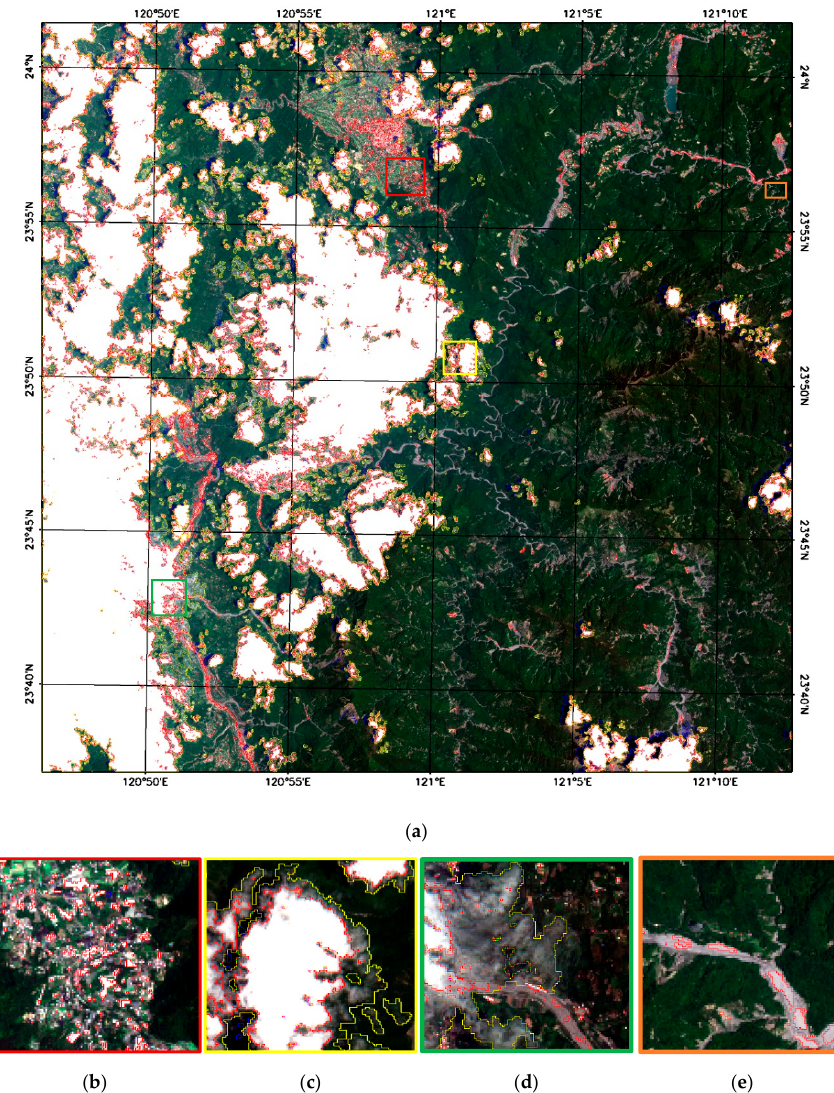
Figure 2. Example of the problems of standard Sentinel-2 Level-2A data products in cloud classification. ( a ) Granule T51QUG and T51QTG taken on 16 May 2018, overlaid by corresponding masks of cloud (red line) and shadow (blue line). The regions of red, yellow, green, and orange boxes are enlarged to illustrate ( b ) the case of misclassified clouds over bright targets; ( c ) the case of misclassified thin clouds; ( d ) the case of misclassified haze; and ( e ) the case of misclassified riverbeds. The manual (visual) cloud masks are annotated as yellow lines.